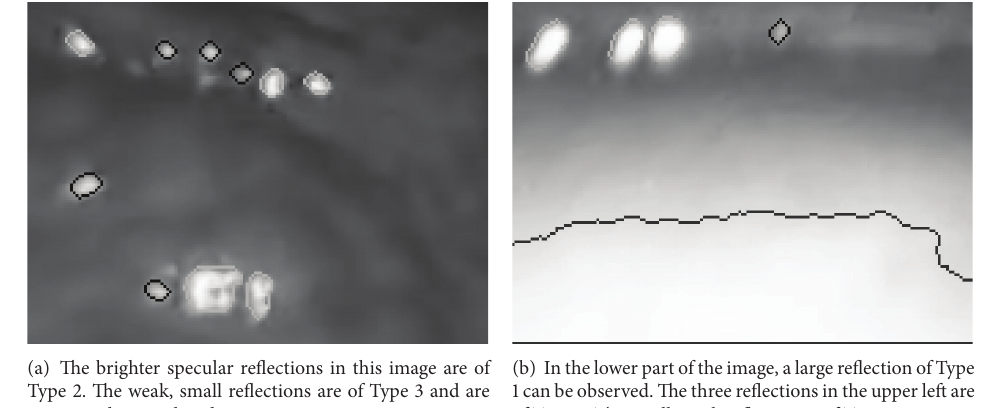
Figure 1: Two regions of interest show reflections of Types 1, 2, and 3. Both images are taken from laparoscopic sequences of the liver. Segmentation is performed using the hybrid contour thresholding